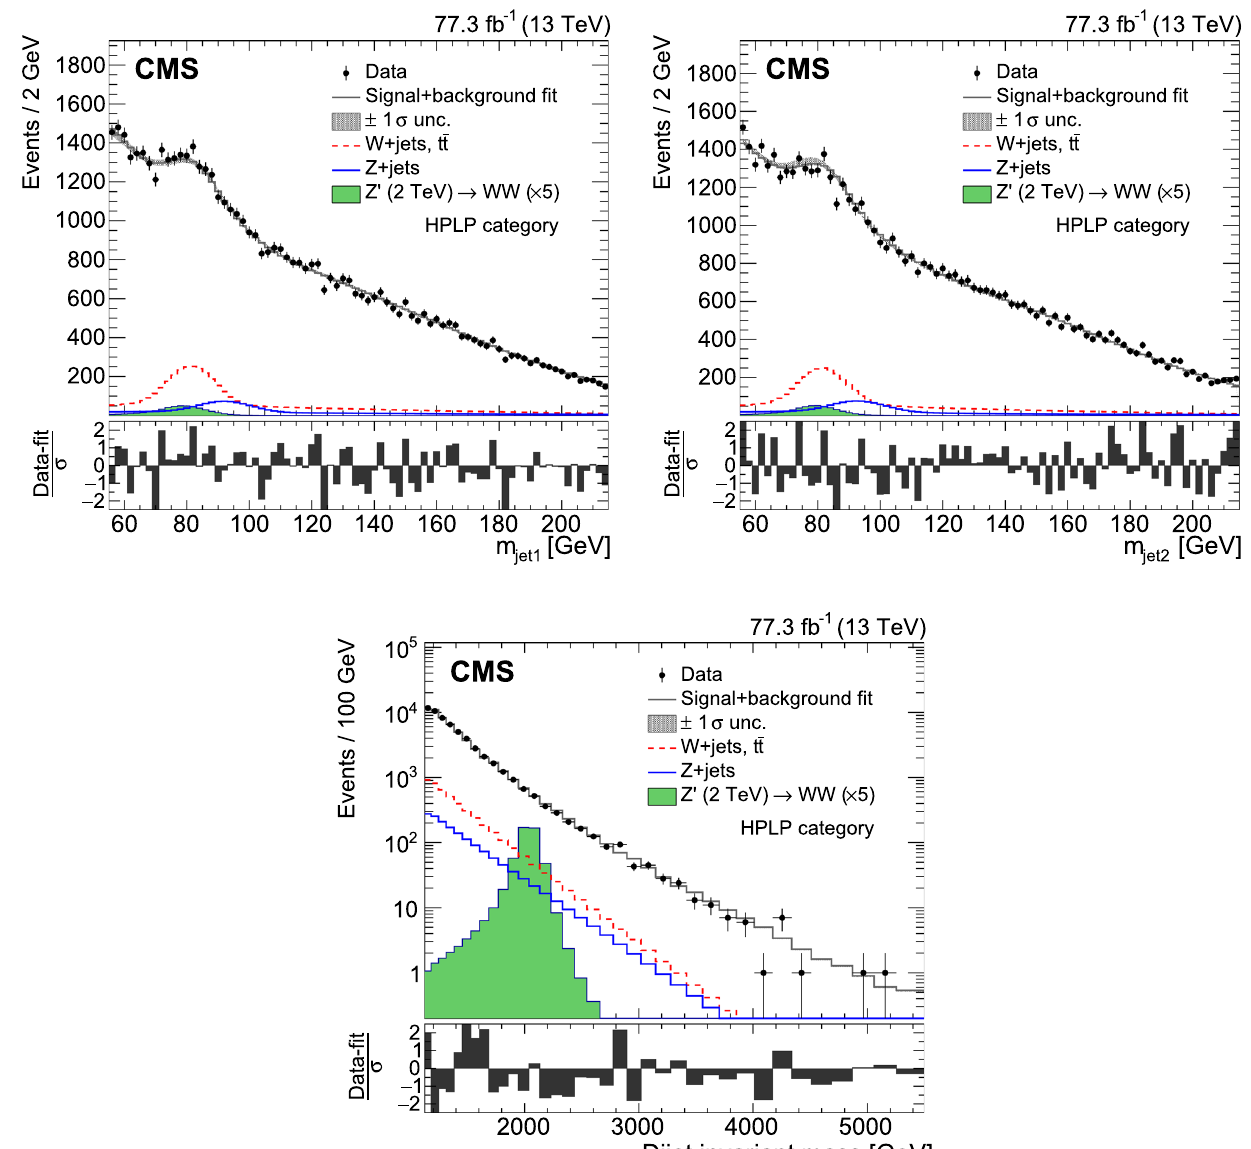
overlaid, where the number of expected events is scaled by a factor of 5. Shown below each mass plot is the corresponding pull distribution (cid:12) ( Data-fit )/σ ,where σ = σ 2 − σ 2 foreachbintoensureaGaussian data fit pull-distribution, as defined in Ref.